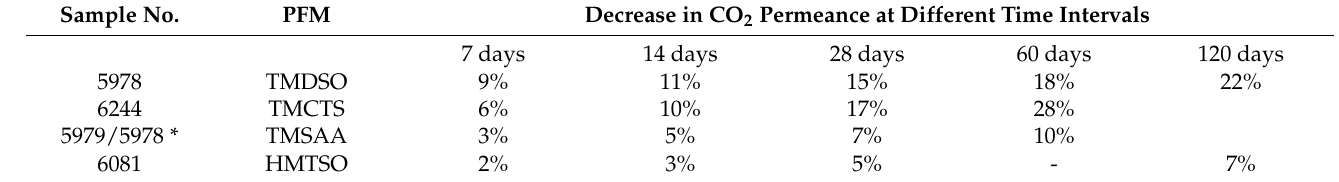
Table 10. Effect of aging in air on CO 2 gas permeance for membranes made from TMDSO, TMCTS, TMSAA, and HMTSO polymers (substrate